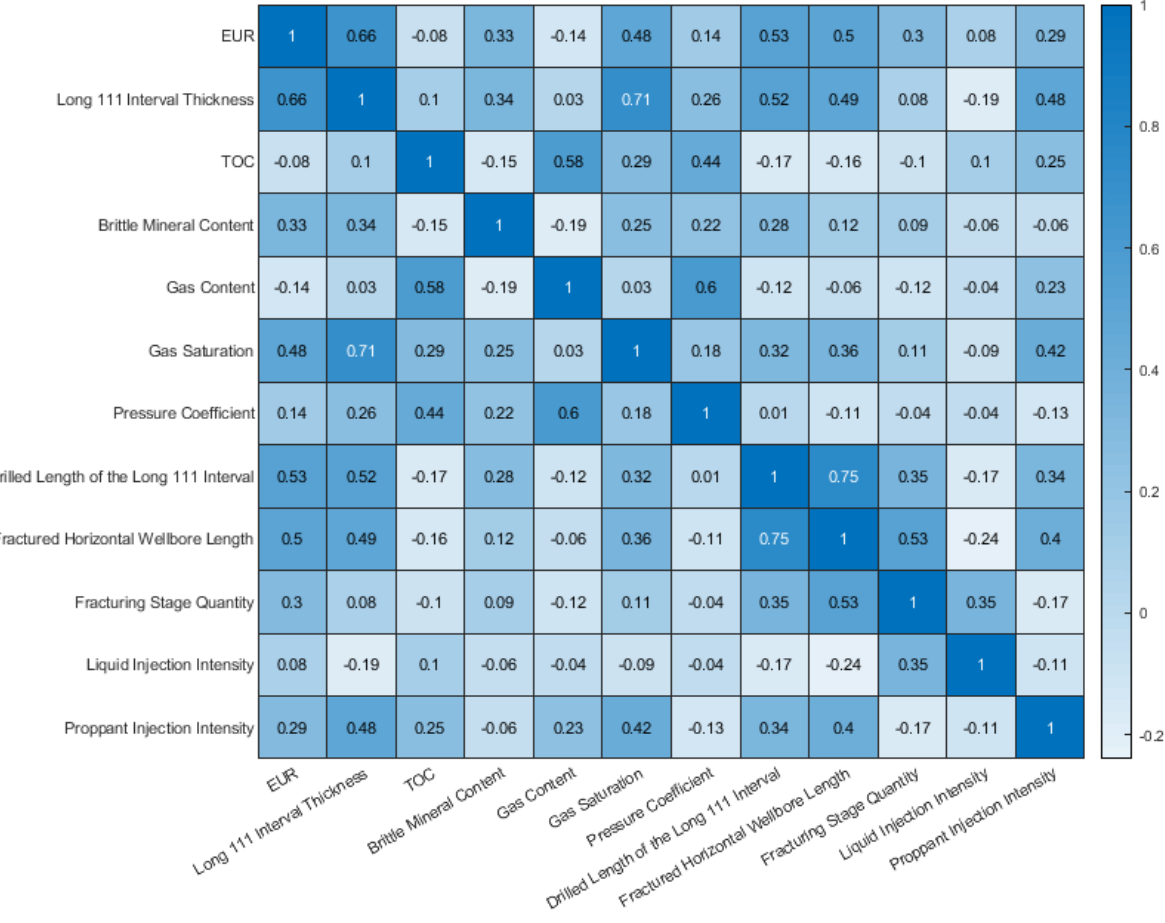
Figure 4. Heat map of the single-factor analysis results.